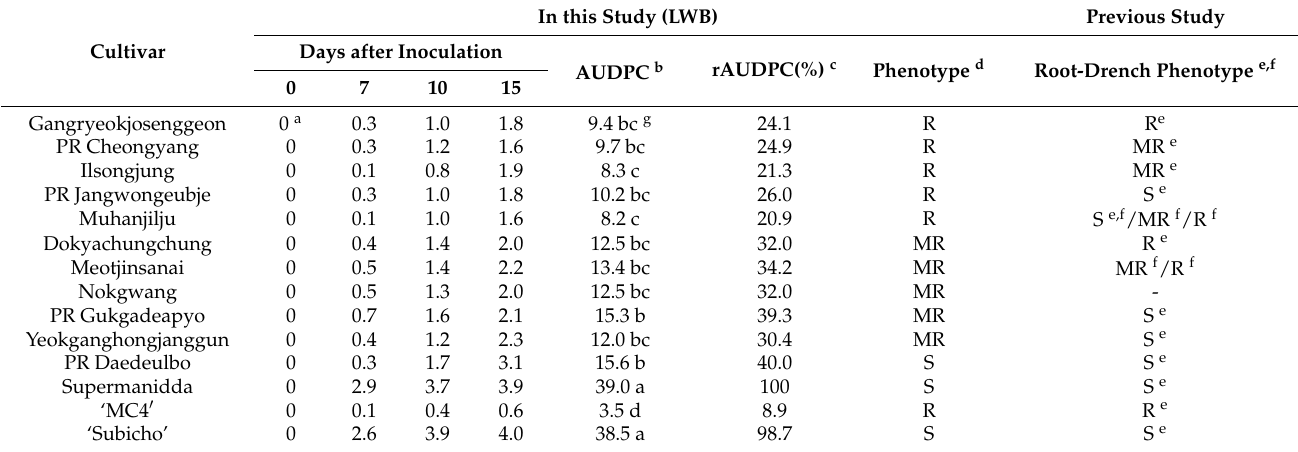
a Disease severity index (DSI) was represented by a 0 to 4 rating scale. b The AUDPC was calculated based on DSI scores evaluated at 0, 7, 10, and 15 days after inoculation (dai). c Relative (r) AUDPC (%) of each cultivar to AUDPC of the ‘Suppermanidda’ that is most the susceptible cultivar. d DSI of <2 is considered resistant, 2 ≤ DSI < 3 is moderately resistant and susceptible was defined with DSI of ≥ 3. Each data point represents the mean DSI from three independent experiments. A total of 30 plants were analyzed for each